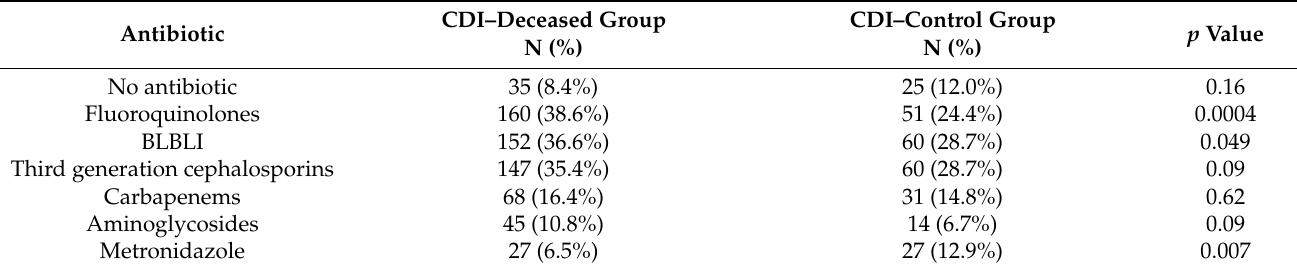
Table 2. Antibiotics used in the 3 months prior to the episode of